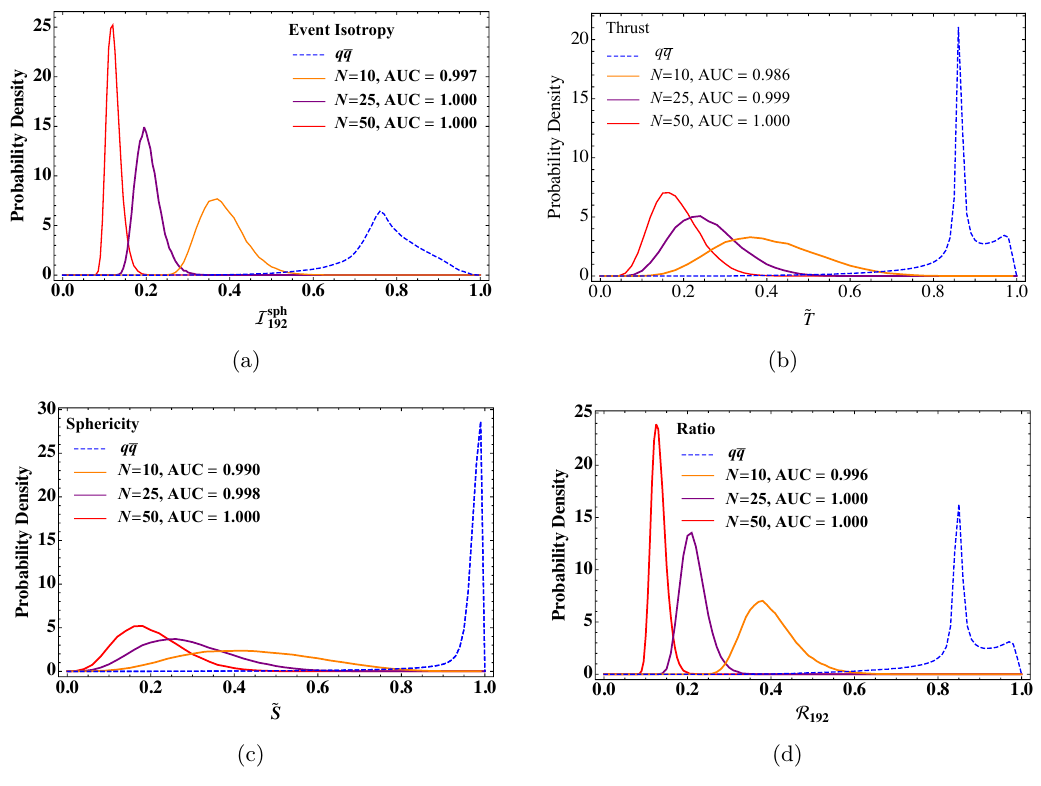
Figure 8 . Comparing the q (cid:22) q background to uniform N -body samples with N = f 10 ; 25 ; 50 g , using the same observables as (cid:12)gure 6 in e + e (cid:0) collisions at correspond to the separation power with respect to the q (cid:22) q